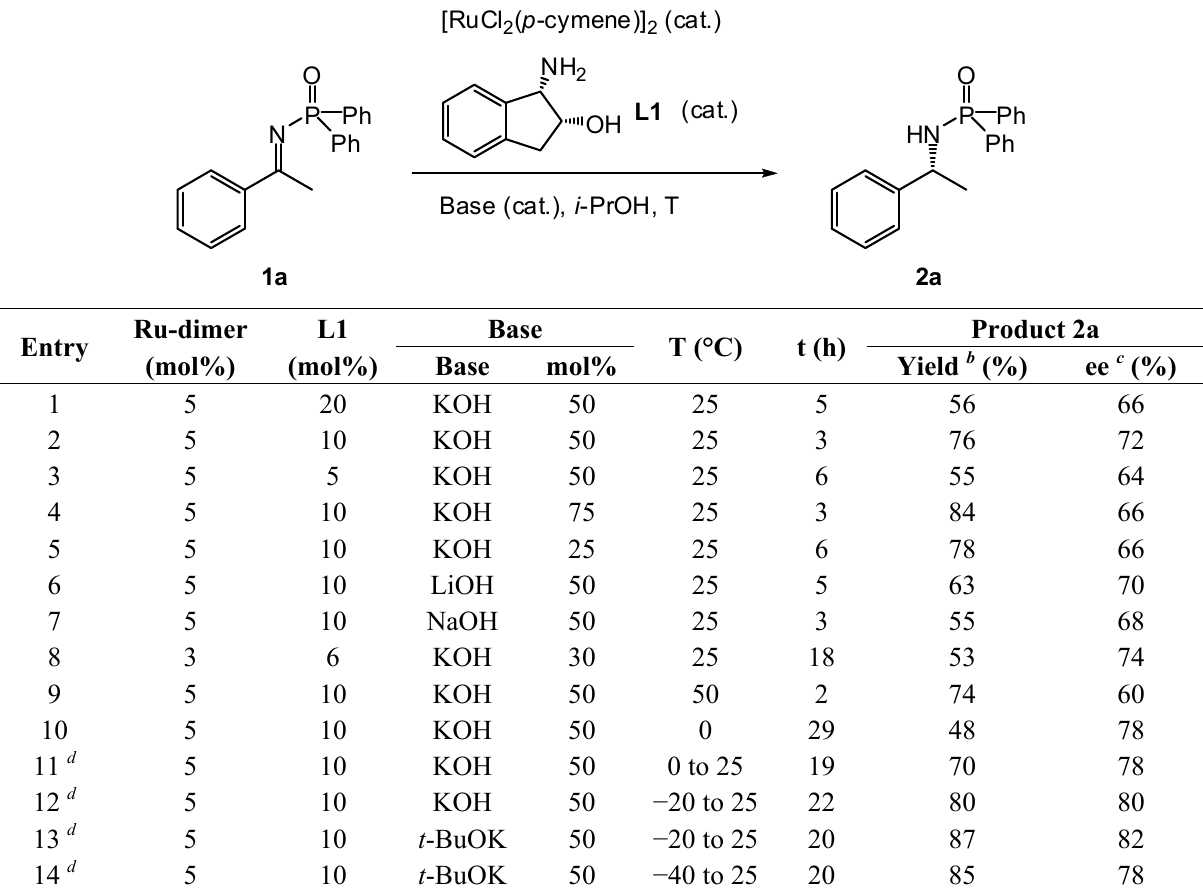
Table 1. Ruthenium-catalyzed asymmetric transfer hydrogenation of N -(diphenylphosphinyl)- -ketimine 1a in isopropyl alcohol. Optimization of the reaction conditions a